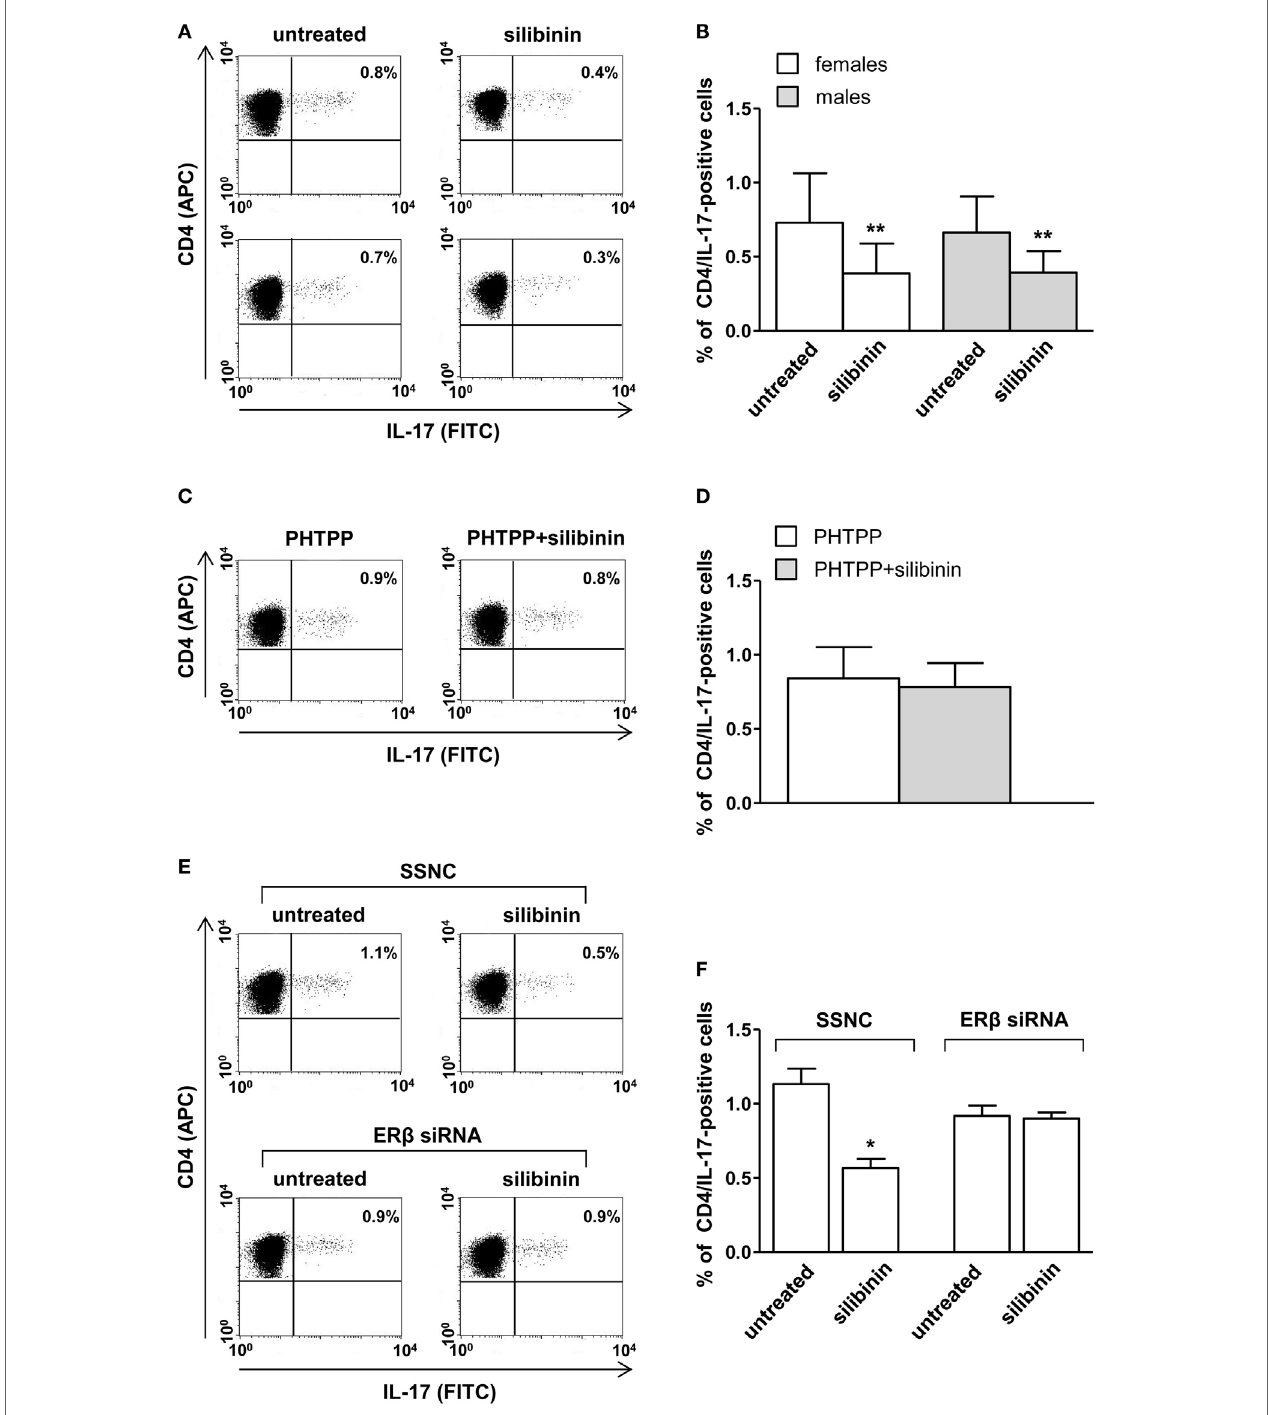
FigUre 3 | Silibinin decreased IL-17 expression in peripheral blood T lymphocytes from female and male healthy subjects acting through estrogen receptor (ER) β binding. (a,b) Cytokine expression was analyzed in 23 female and 21 male healthy subjects by flow cytometry after 48 h of culture with silibinin and stimulation with phorbol myristate acetate (PMA) and ionomycin in the presence of brefeldin for the last 4 h of culture as detailed in Section “Materials and Methods.” Results from representative female (upper panels) and male (lower panels) healthy donors are shown (a) . Data are also reported as mean ± SD (b) . (c,D) IL-17 expression was analyzed in T lymphocytes from three randomly selected female healthy donors pretreated with the ER β antagonist PHTTP for 1 h before adding silibinin. Results from a representative female healthy donor are shown (c) . Data are also reported as mean ± SD (D) . (e,F) IL-17 expression was analyzed in T lymphocytes from three randomly selected female healthy donors after silencing ER β expression. Results from a representative female healthy donor are shown (e) . Data are also reported as mean ± SD (F) . * P < 0.05, ** P < 0.01 versus untreated cells. Abbreviation: SSNC, silencer select negative control